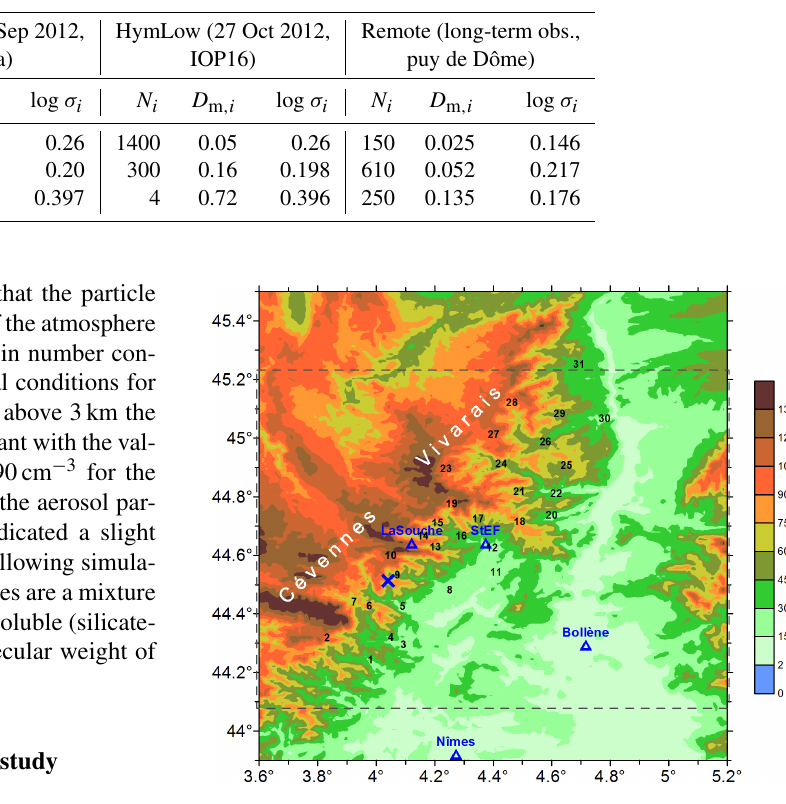
Figure 3. Topographical map of the region (altitude in metres) of strong precipitation during IOP7a. Numbers indicate the locations of rain gauges used for this study. The dotted lines show the inner- most model domain. Disdrometer measurements were made at La Souche and at Saint-Étienne-de-Fontbellon (StEF), S-band radars of Météo-France are located at Nîmes and Bollène, and X-band radar is located at La Bombine indicated by the blue